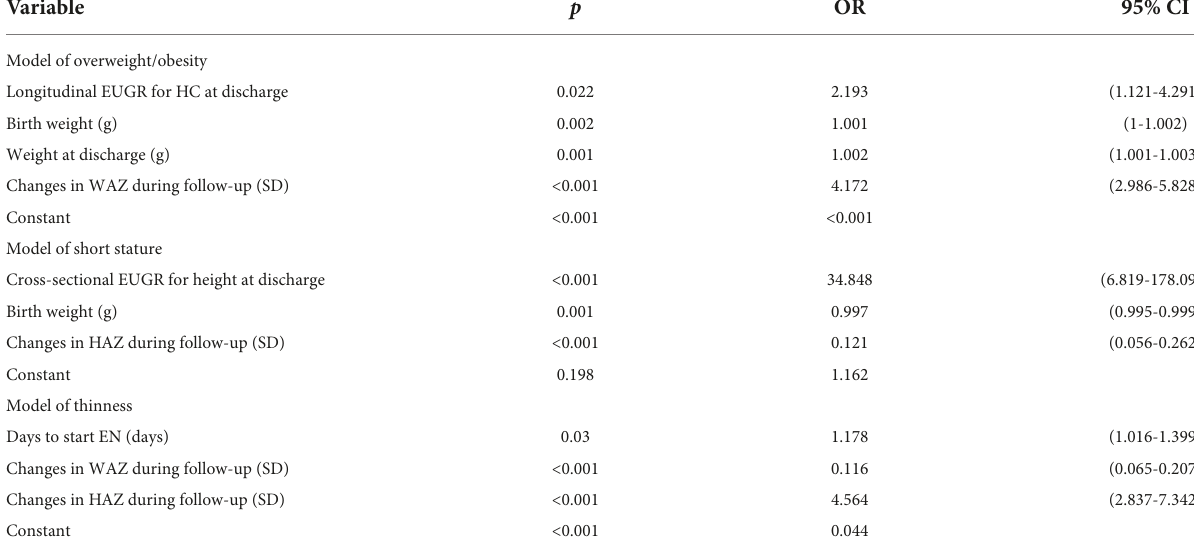
TABLE 4 Multilogistic regression model of overweight/obesity, short stature, and thinness at age 3-6 years. Variable Model of